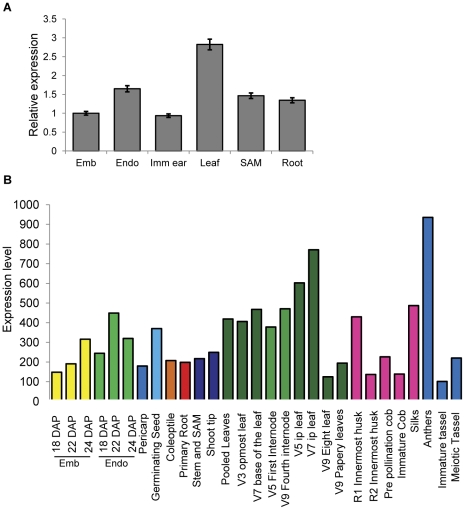
Expression pattern of maize brd1 gene in various plant tissues.
A Relative expression levels of maize brd1 based on qRT-PCR analysis. cDNA was synthesized from total RNA isolated from 14 days after pollination embryo (Emb) and endosperm (endo), immature ear (Imm ear), leaf (14 day old seedling), shoot apical meristem-enriched tissue (SAM), and root (14 day old seedling) tissue. The expression level of brd1 was normalized to the expression of the house-keeping mez2 gene and shown relative to the expression of the wild type plants grown without brassinolide. Bars represent standard deviation values. B Expression levels of Zmbrd1 in various plant tissues based on Maize Expression Atlas [28].